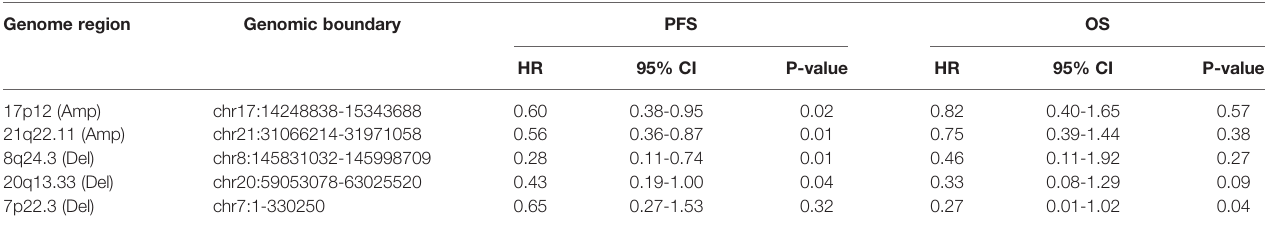
P-values were calculated by log-rank